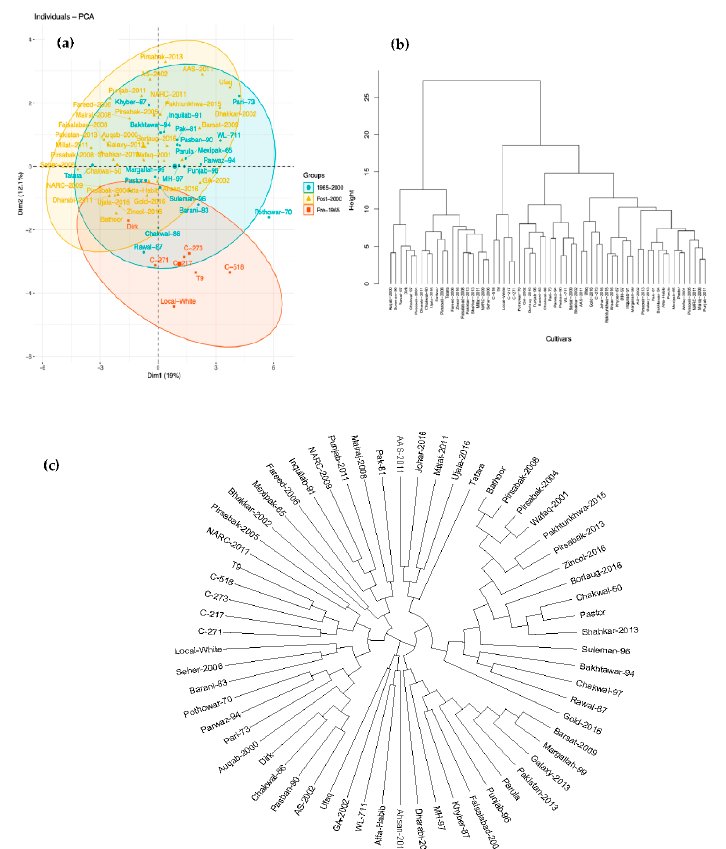
Figure 3. Multivariate analysis of historical wheat cultivars based on morphological traits and micronutrients, and genome-wide SNP markers. ( a ) Principal components analysis-based biplot showing scattering of wheat cultivars grouped based on three breeding periods, ( b ) dendrogram showing clustering of wheat cultivars based on morphological traits and micronutrients, ( c ) dendrogram showing clustering of wheat cultivars based on genome-wide SNP markers.